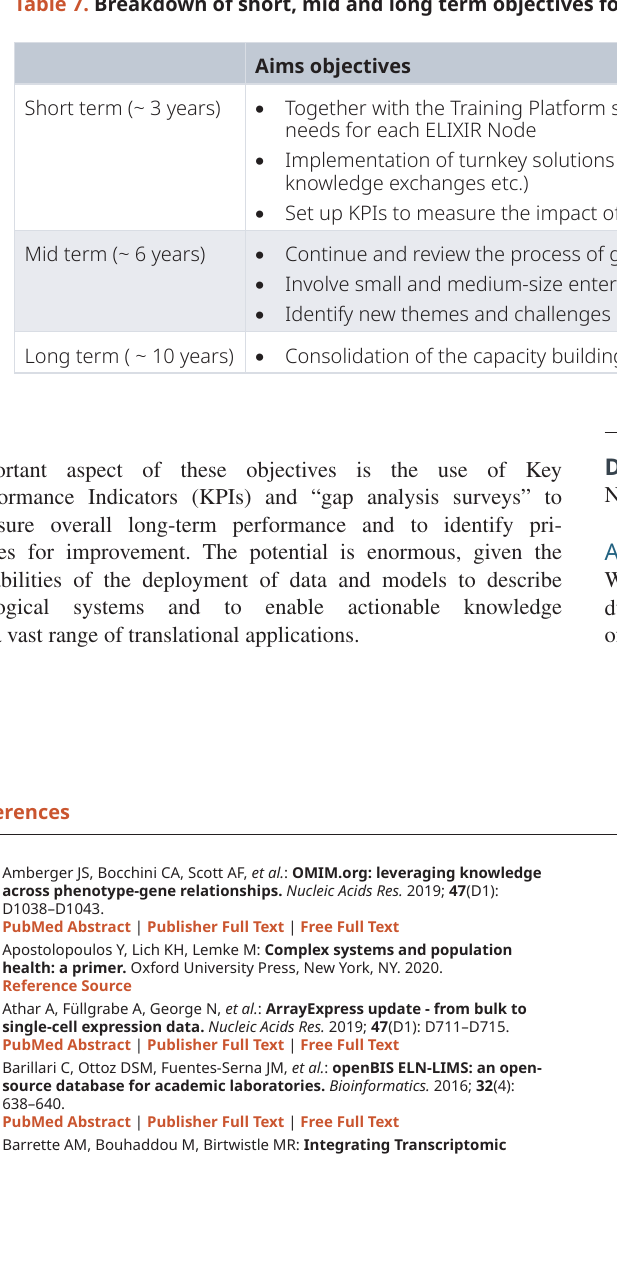
Table 7. Breakdown of short, mid and long term objectives for the Industrial embedding